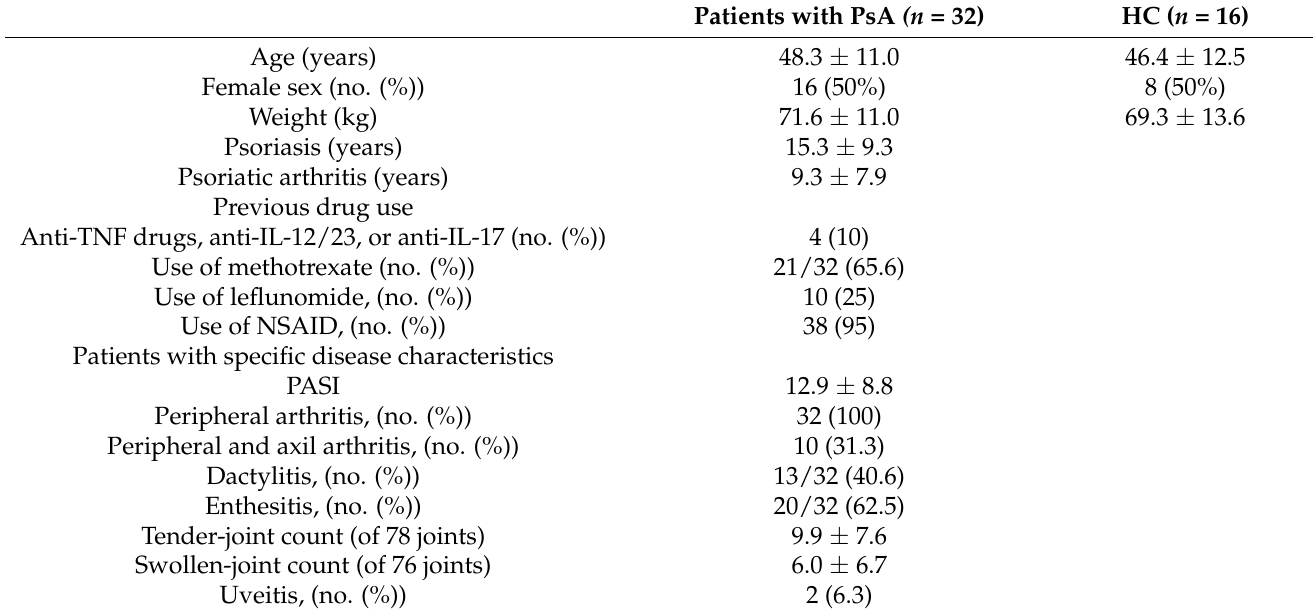
Table 1. Demographics of patients with psoriatic arthritis (PsA) and healthy controls